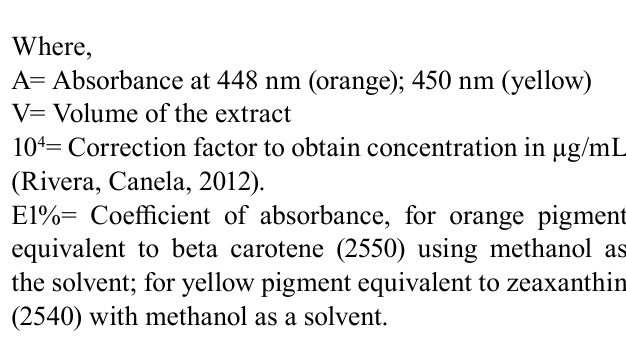
TABLE I – N ormalized product function used in the calculation of SPF (Sayre, et al .,